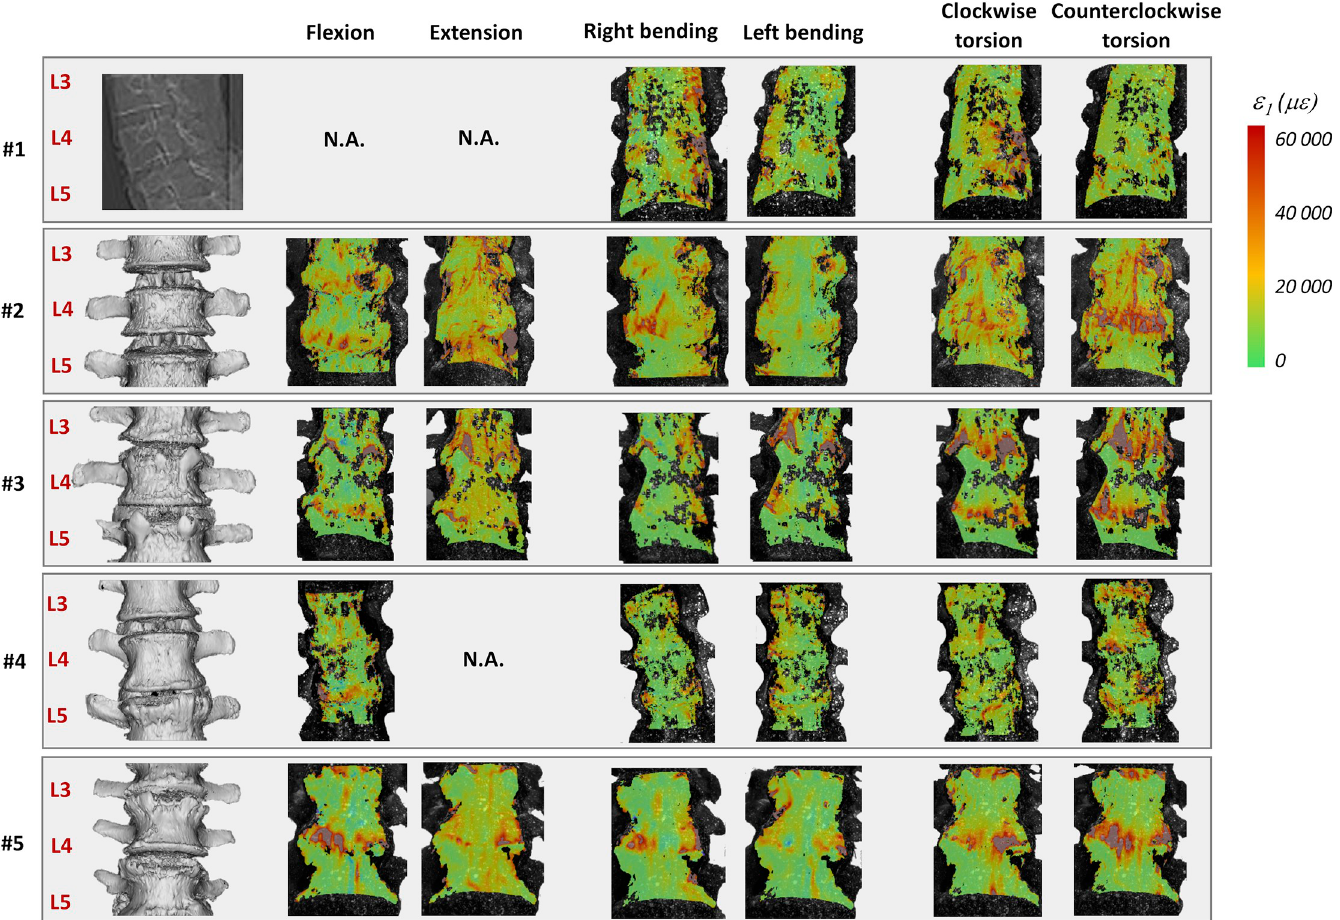
Fig 8. Specimen-specific analysis of the strain distribution: the CT images of each specimen are reported on the left (for Specimen #1 the CT was not available). On the right, the distribution of the maximum principal strain (eps 1 ) are plotted for each loading condition, at full load (7.5 Nm). The minimum principal strain (eps 2 ) and the analysis of the circumferential and cranio-caudal distribution of strain of the vertebra and the IVD are reported in the S1 Fig, S1 and S2 Dataset.